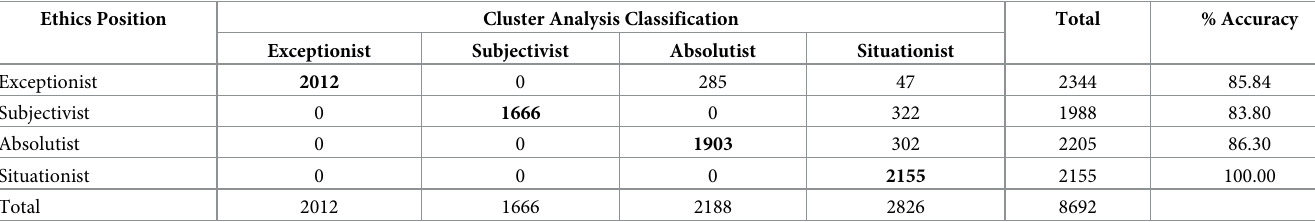
Table 5. Ethics position as determined by relative idealism and relativism scores (EPQ classification) and by cluster analysis. Ethics